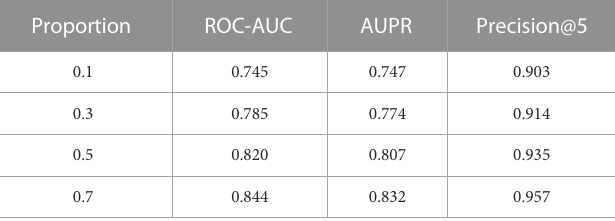
TABLE 4 Performance comparison with different training sample sizes. The evaluationisunder leave-gene-combination-outsettinginK562cell linedataset. Theproportioncolumnindicatestheproportionoftotalsamplesusedastraining samples. Proportion ROC-AUC AUPR